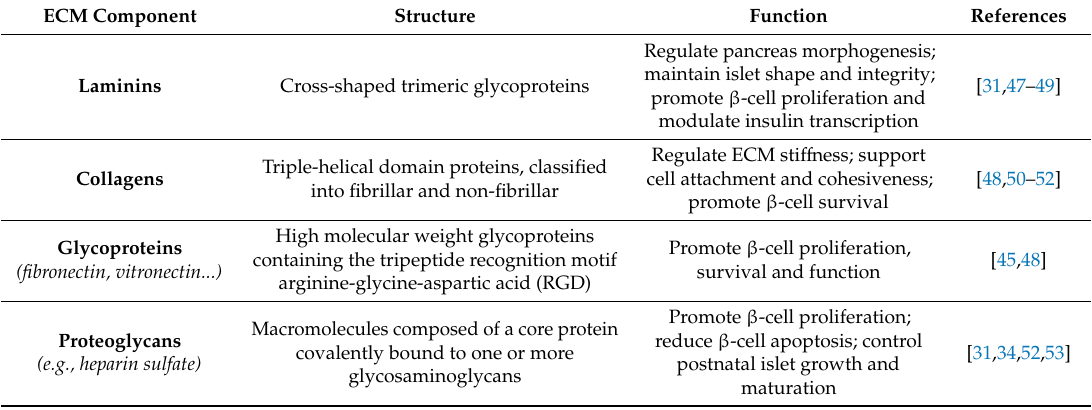
Table 1. ECM components involved in islet development and β -cell survival and function ECM Component Structure Function Regulate pancreas morphogenesis; maintain islet shape and integrity; Laminins Cross-shaped trimeric glycoproteins